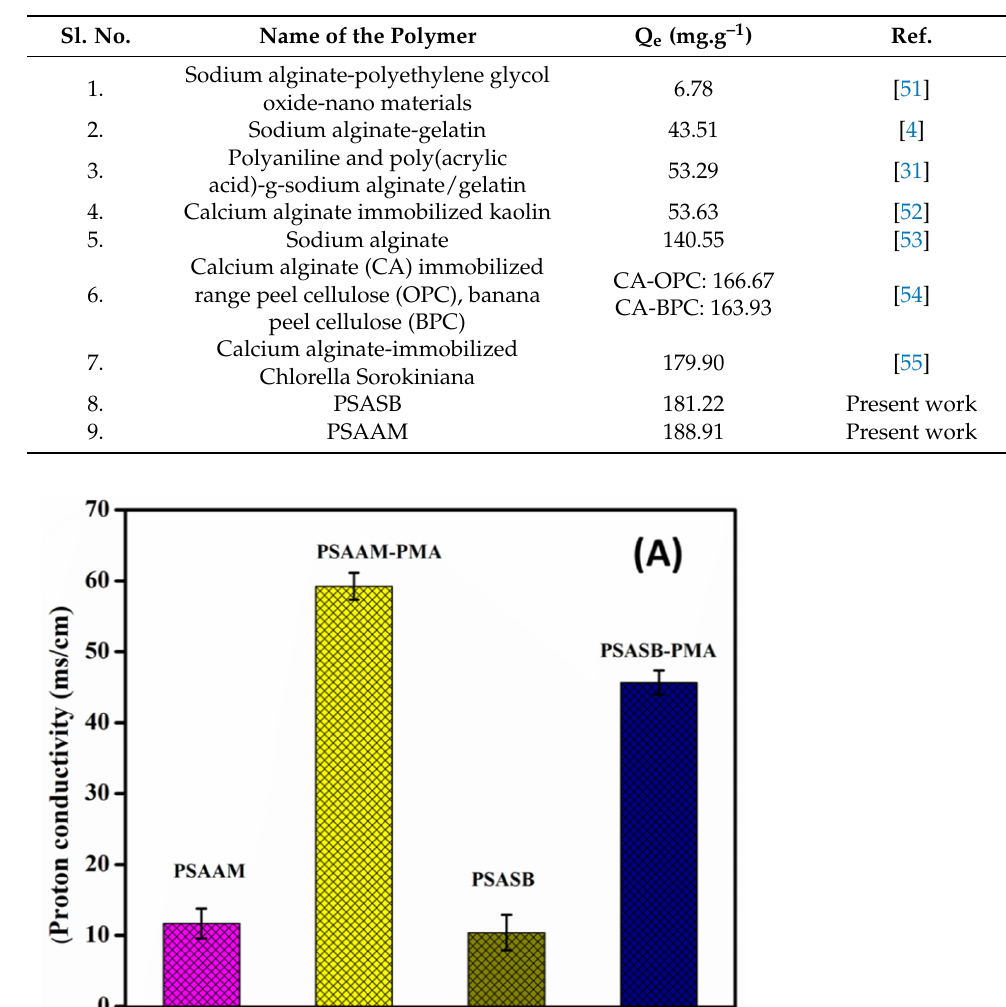
Table 2. Comparison of maximum adsorption capacity of Cu(II) ion by SA based materials.